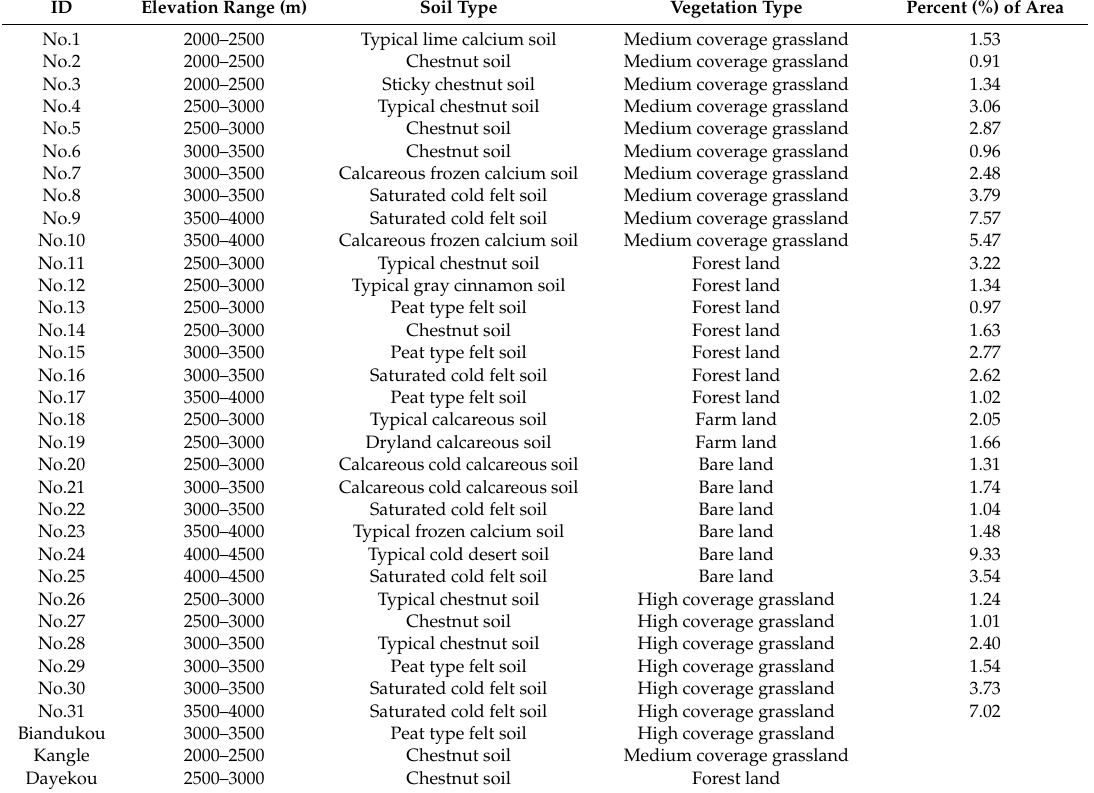
Table 1. Soil and vegetation types at the in situ observation sites and automatic meteorological